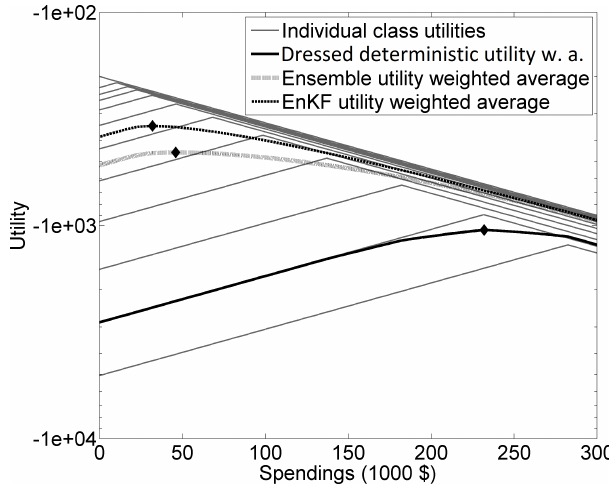
Figure 8. Utility as a function of money spent for forecasts emitted on 17 May 2014 for each of the three forecasting systems. Thin grey curves represent the utility of any decision given the 12 classes of events. Thick curves show the utility of forecasting system. Maxima of each system are indicated by a diamond marker. Calculations are for A = 0 . 01 and ψ =